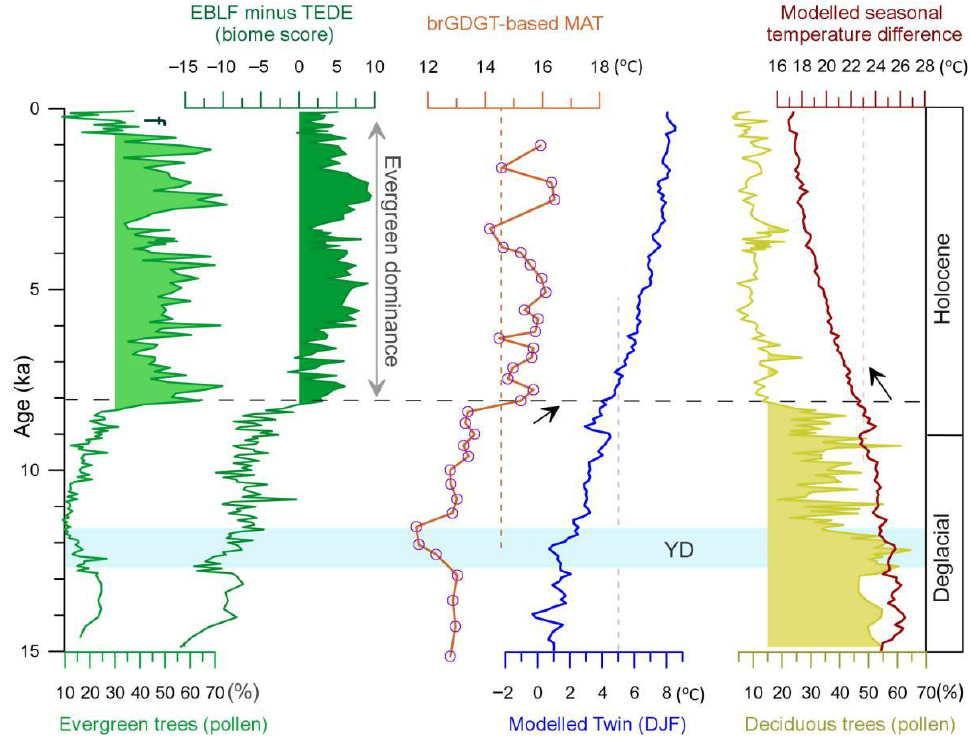
Figure 5. Temperature and seasonal difference as the key factors of evergreen forest turnover during the Holocene. Temperature indices including brGDGT-based mean annual temperature reconstruction [27], TRACE21 [18] modeled winter temperature (Twin) and seasonal mean temperature difference between July and January. The values of the two variables were revised from the regional output according to the local air temperature (SZY).